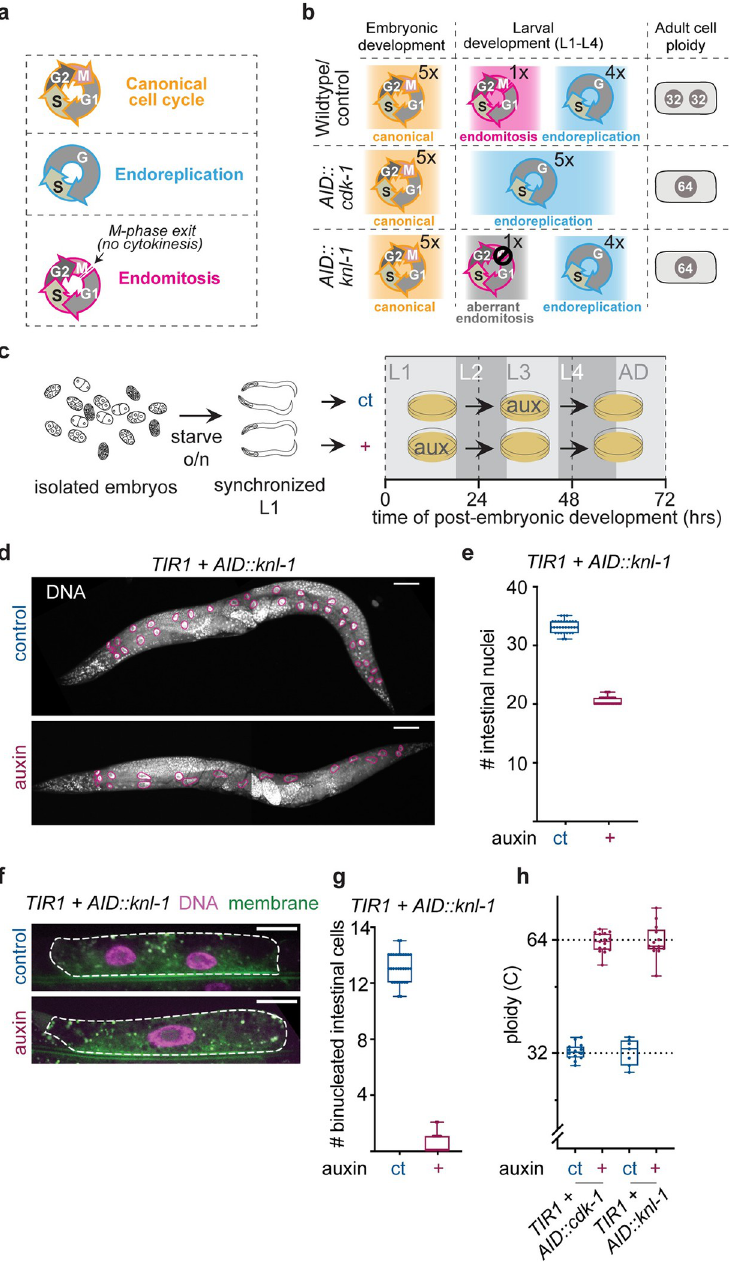
Fig 1. Inducible and tissue-specific degradation of mitotic proteins specifically prevents binucleation of the C . elegans intestine. (A) Three types of cell cycles that take place during intestinal development in C . elegans . (B) Overview of intestinal cell cycles in wild-type/control animals and upon intestinal depletion of CDK-1 or KNL-1. In wild-type C . elegans , 20 intestinal cells are formed during embryogenesis by canonical cell cycles. During the first larval stage (L1) intestinal cells undergo one round of endomitosis creating binucleated cells. Thereafter, intestinal cells undergo one round of endoreplication at the end of each larval stage, leading to adult intestinal cells with two 32C nuclei (and thus a cellular ploidy of 64C DNA content). Upon inhibition of either CDK-1 or KNL-1 during endomitosis using the auxin-inducible degradation system, endomitotic binucleation is blocked, and a mononucleated polyploid cell is generated. Importantly, cellular ploidy remains the same as wild-type conditions (64C). (C) Schematic overview of experimental procedure. Mixed stage embryos are isolated from adult hermaphrodites containing intestinally expressed TIR1 ( Pges-1 :: TIR1 ) and either AID :: cdk-1 or AID :: knl-1 and starved overnight to yield a synchronized population of arrested L1 animals. The population of starved L1 animals is split into 2 conditions: an auxin (+) condition and a control (ct) condition. For the auxin condition, animals are grown on plates containing